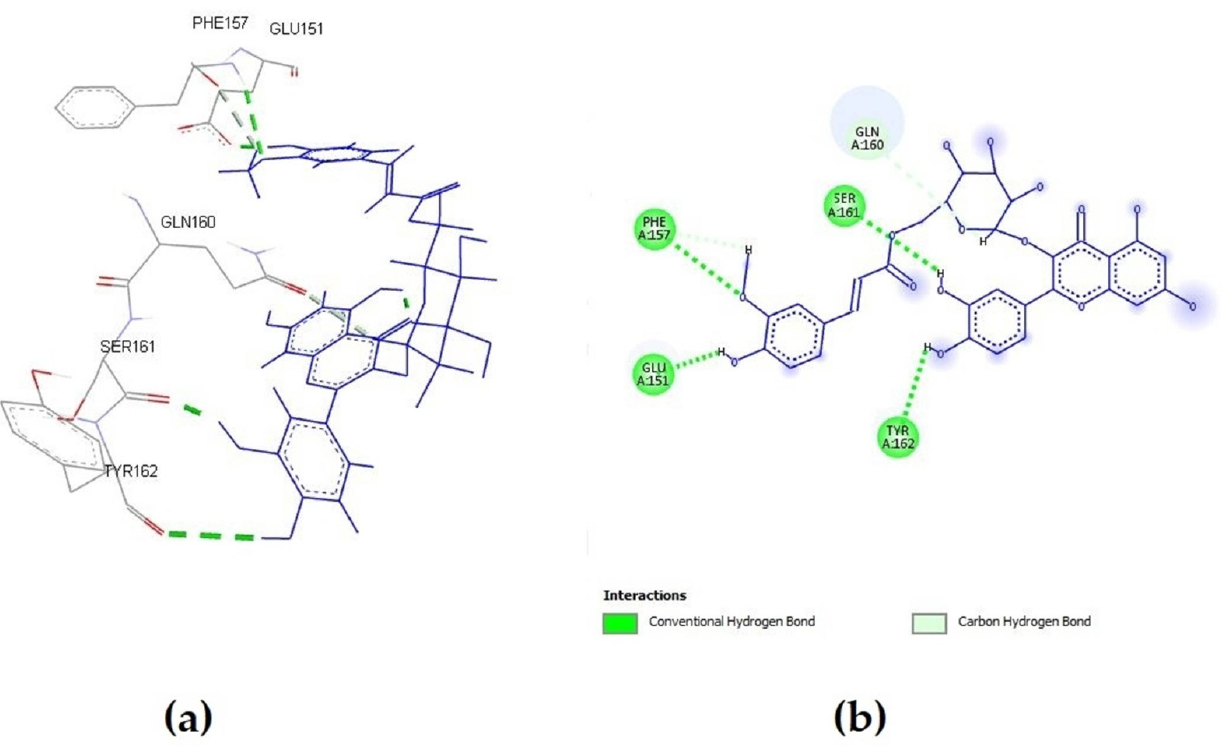
Figure 2. Quercetin 3-(6”-ferulylglucoside) interactions with S-glycoprotein (wild); ( a ) the most favor- able binding pose of the compound; ( b ) 2D illustration of interaction types between the compound and target residues.